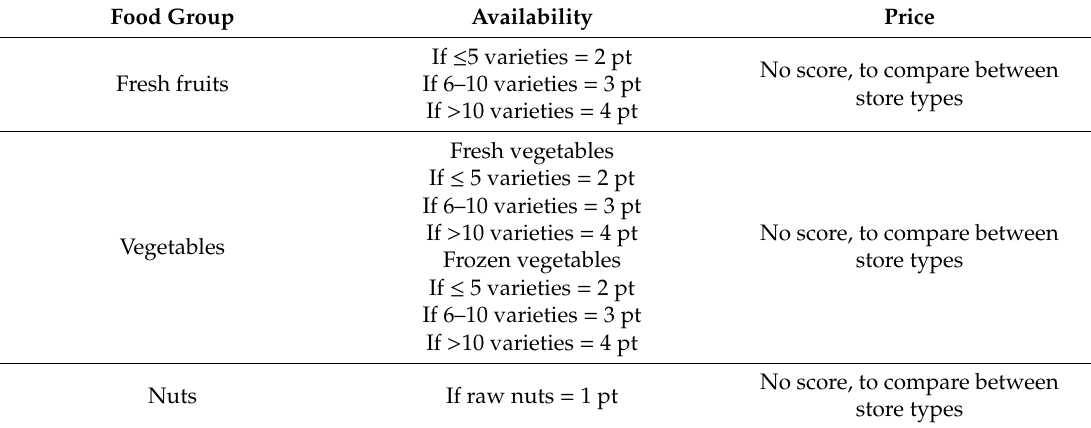
Nutrition Environment Measurement Survey in Stores for Mediterranean contexts NEMS-S-MED